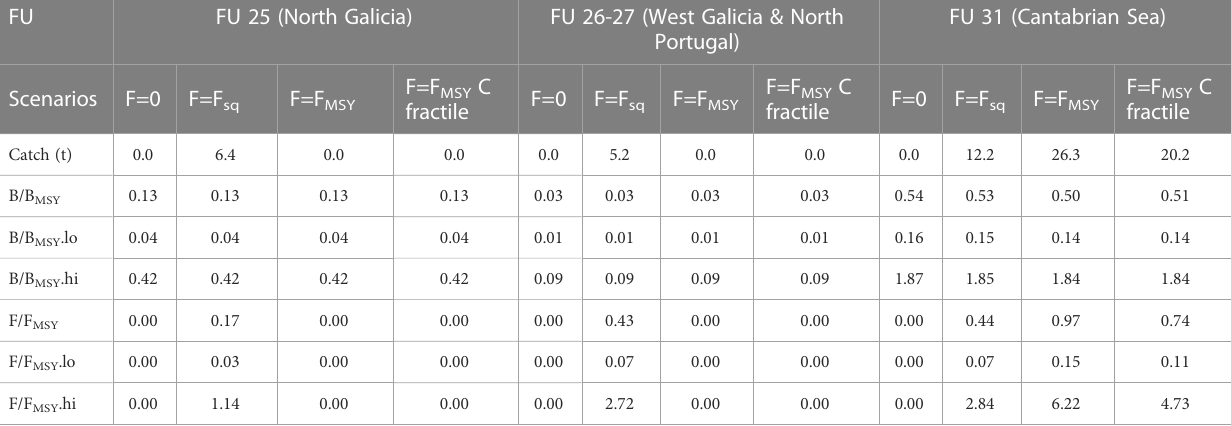
TABLE 3 SPiCT predicted catch and status of the stock for